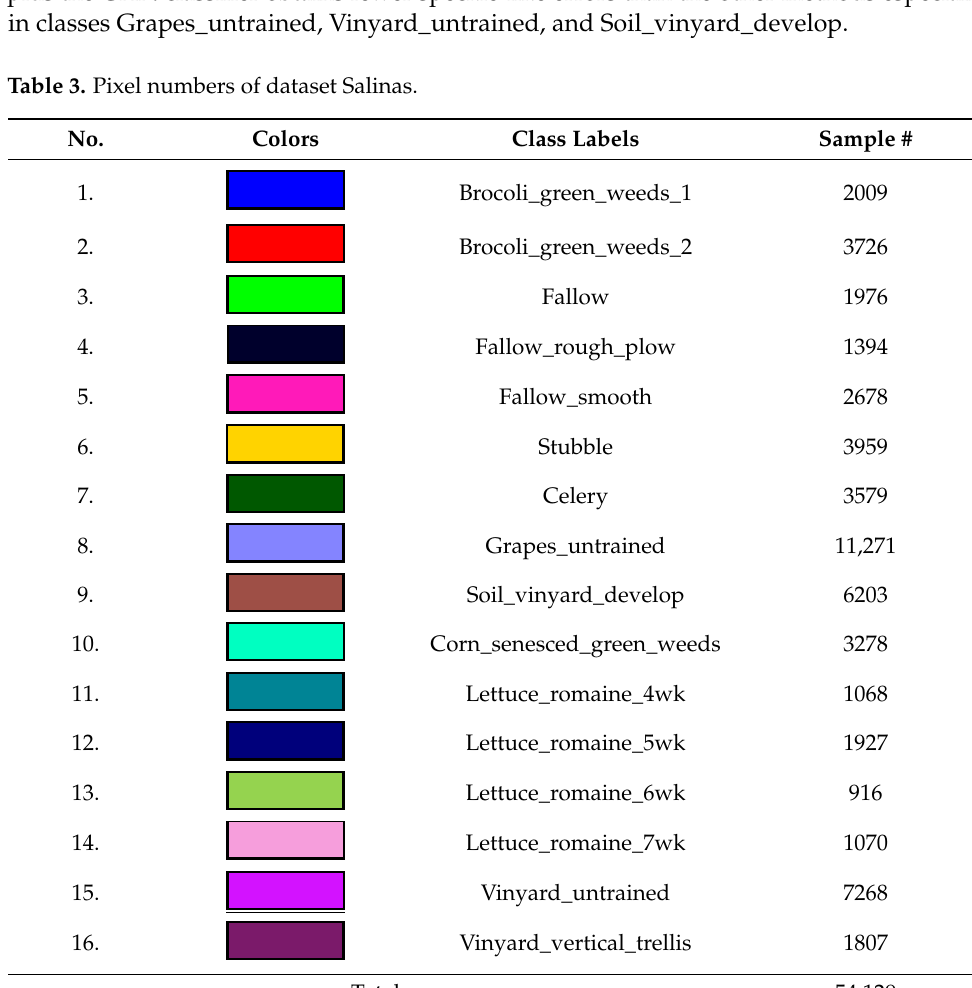
Table 4. The classification results of various DR methods on dataset Salina.